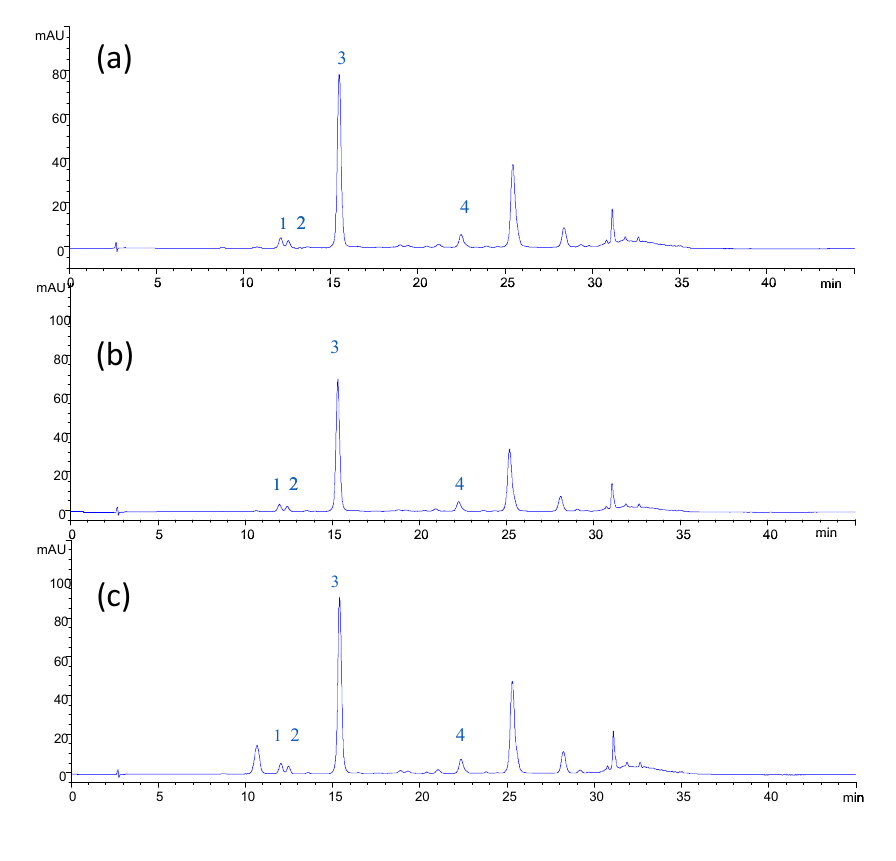
Figure 6. HPLC chromatogram of anthocyanins. ( a ) Clarified press liquor; ( b ) NF retentate; ( c ) OD retentate. Peaks: 1, cyanin chloride; 2, myrtillin chloride; 3, cyanidin-3-glucoside chloride; 4, peonidin-3-glucoside